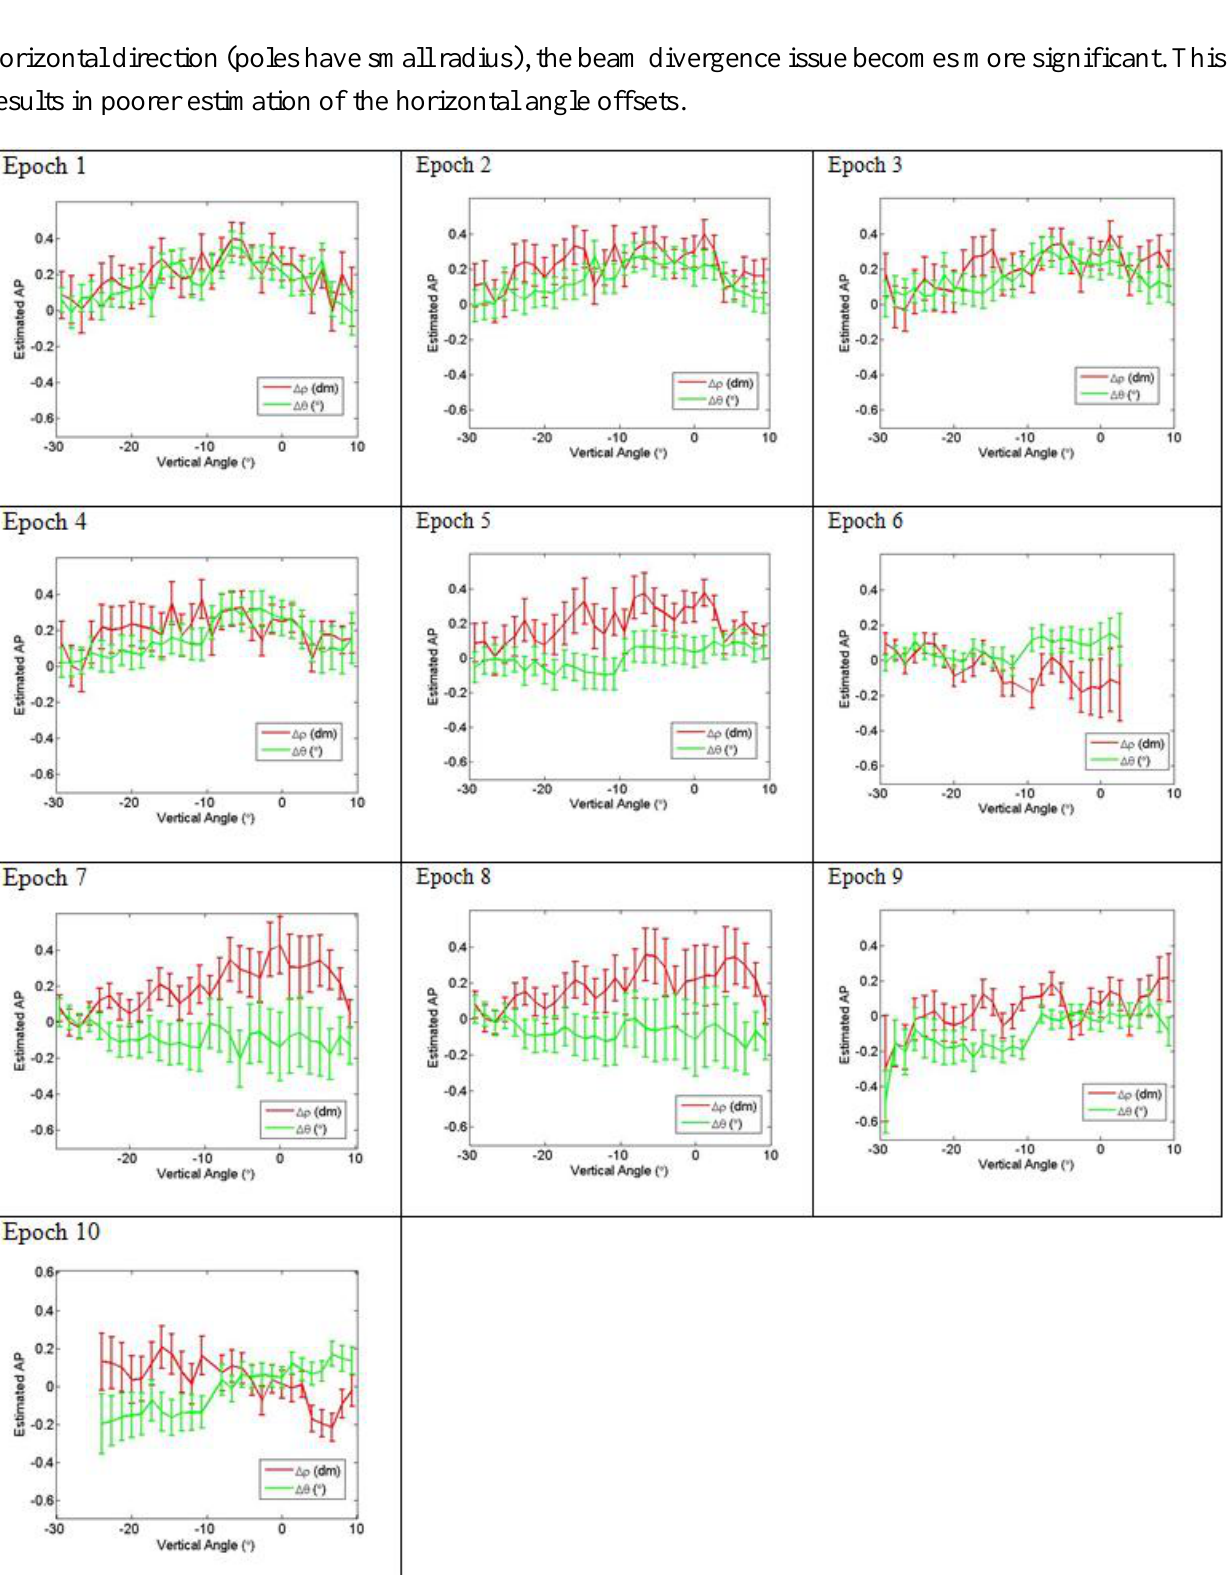
Figure 16. Estimated parameters and their precisions by the proposed calibration in kinematic mode for Dataset 3 over 10 epochs (10 rotations, ~1.4